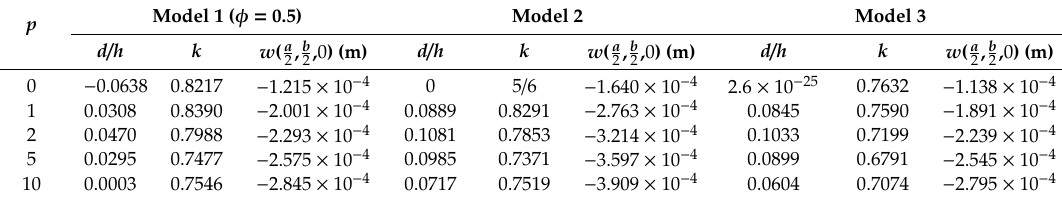
Table 11. Results obtained with the three porosity distribution models